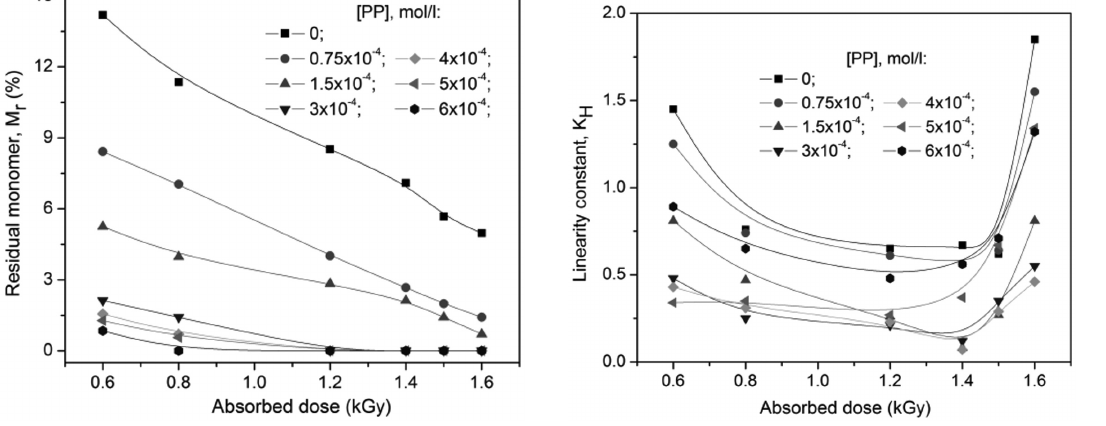
Figure 4. The effect of initiator concentration and EB absorbed dose on linearity constant (k H